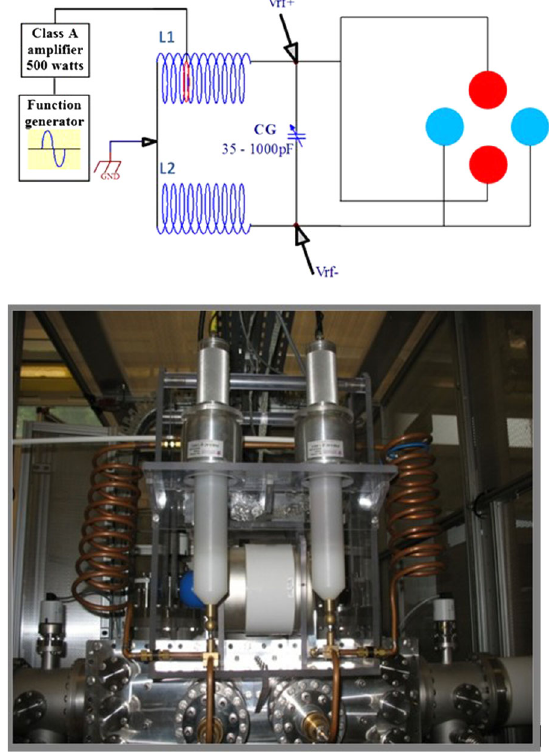
FIG. 3. Design of the rf electronic system (top) and the real rf system of SHIRaC (bottom).